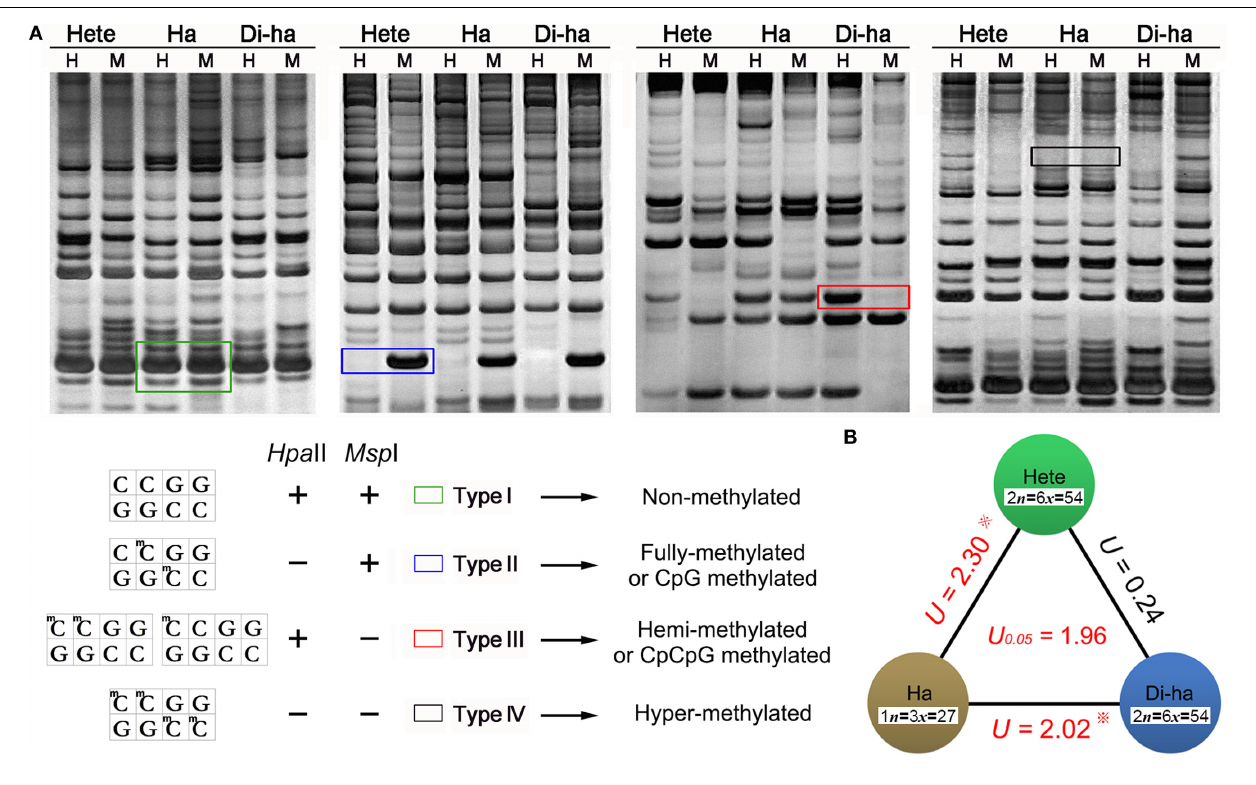
FIGURE 5 | Representative fragments in MSAP profiles. (A) Hpa II and Msp I sensitivities to 5-CCGG methylation status (“ + ”/“ − ”: enzyme can/cannot cut): The four types of fragment generated. Type I: non-methylated, appearing in both the H and M lanes; Type II: fully methylated, present in the M but not the H lanes; Type III: hemi-methylated,